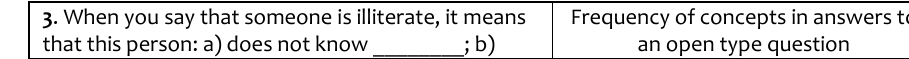
Table 4. Profiling illiteracy as missing at competencies 3 . When you say that someone is illiterate, it